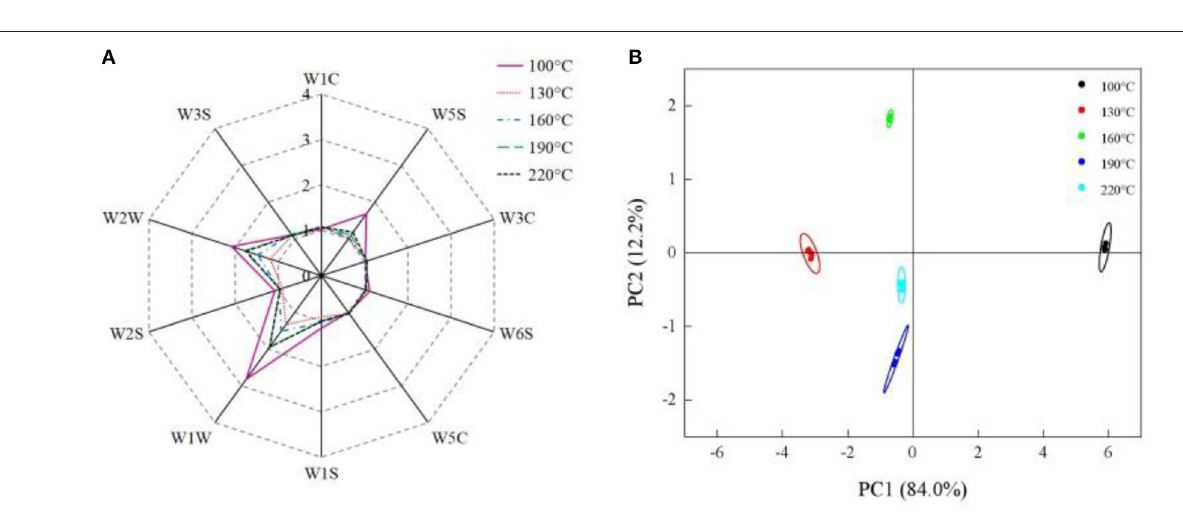
FIGURE 5 | Electronic-nose response data radar chart (A) and principal component analysis plot (B) of eel burgers baked at various temperatures.